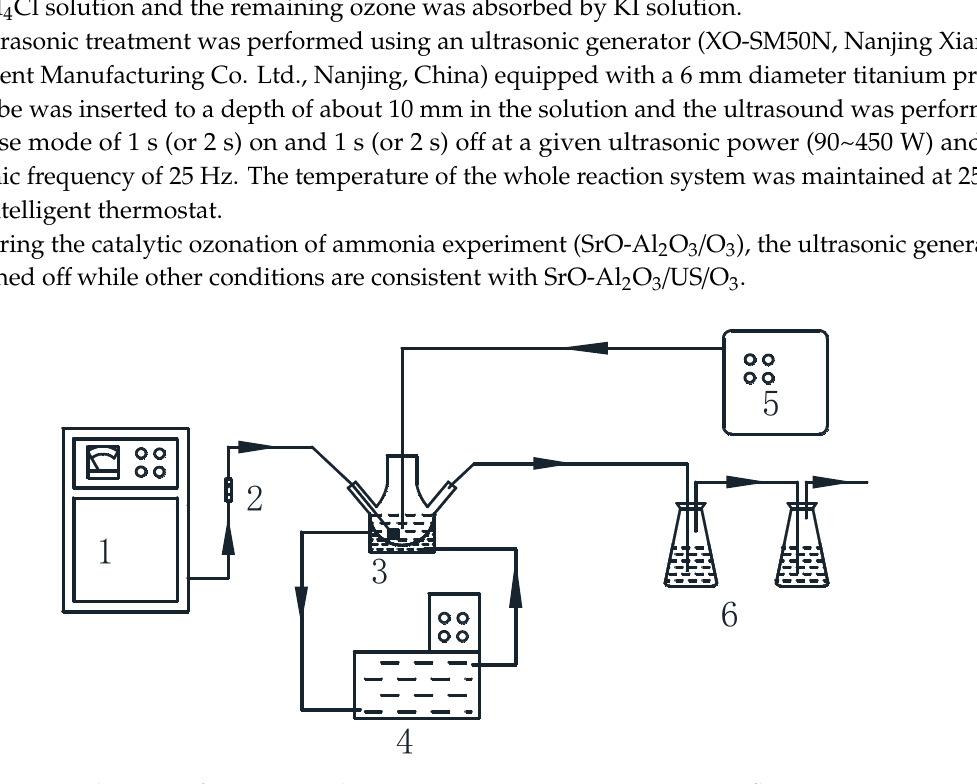
Figure 1. Schematic of experimental apparatus. 1 Ozone generator, 2 Gas-flowmeter, 3 Reactor, 4 Intelligent cryostat, 5 Ultrasonic generator, 6 KI absorption liquid.